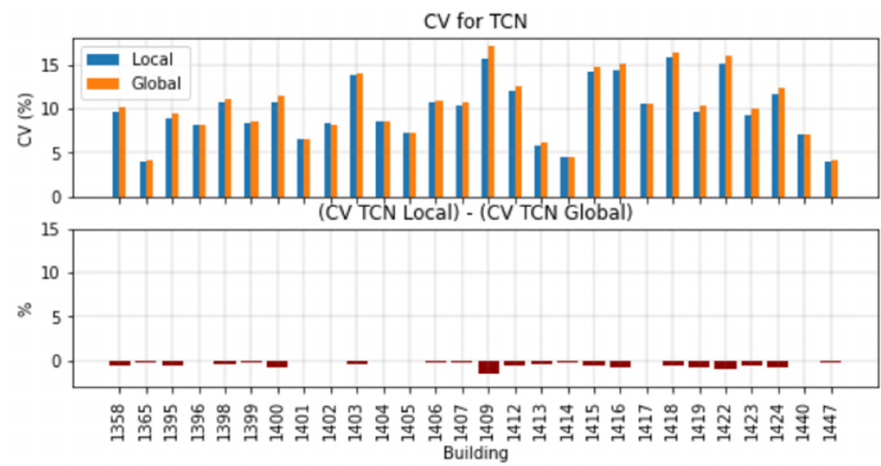
Figure 9. Comparison (in the upper figure) and difference (in the lower figure) between the CV obtained from local and global TCN models on test set.